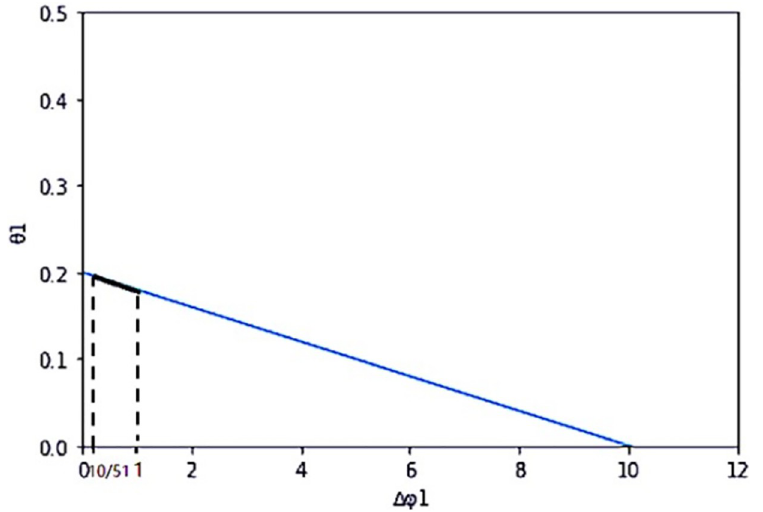
Fig 4. The functional relationship between θ 1 and Δ φ 1 .